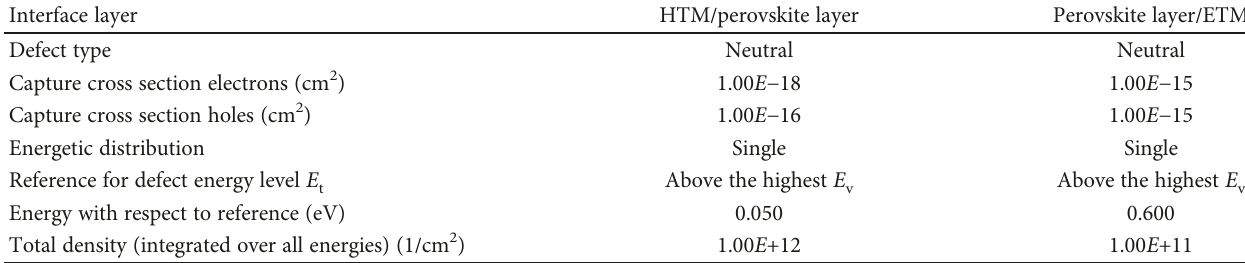
Table 2: Parameters of interface layer.